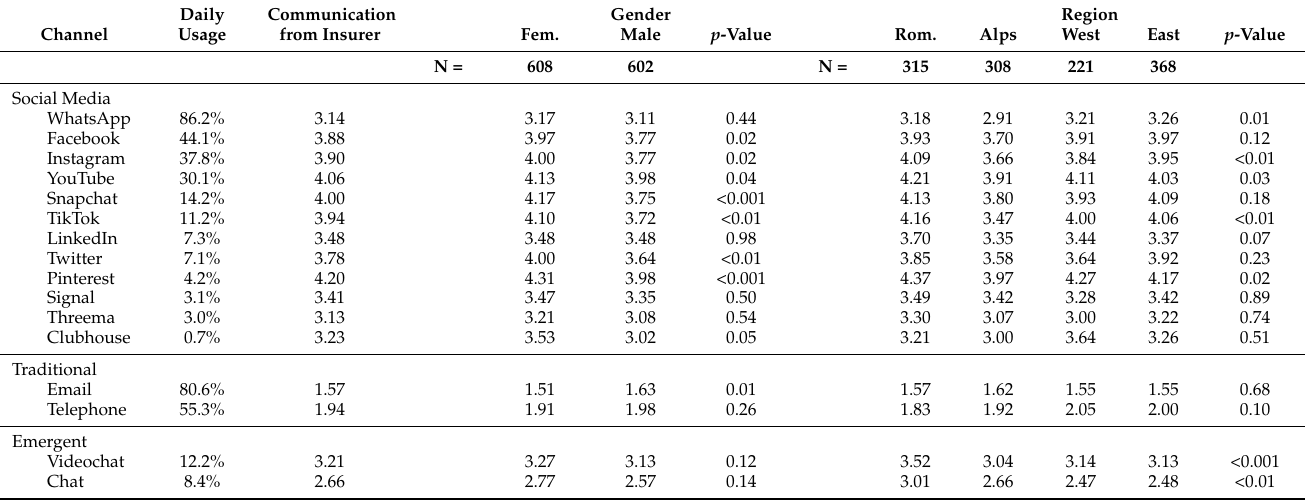
Table 1. Opinion on communication from insurers by channel (1 = very good, 5 = not good at